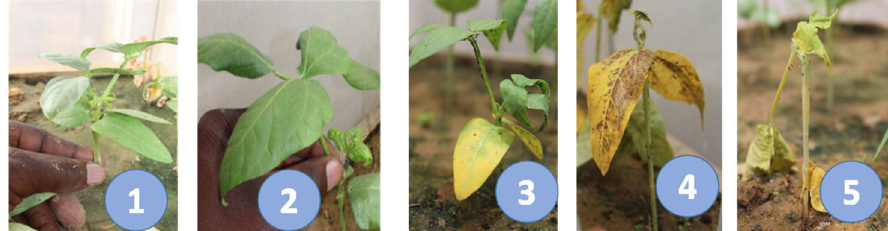
Figure 1. Aphid damage severity rating scale. The damage scored on a scale of 1–5 [7]), where 1 = no damage or symptoms on the leaves, 2 = fewer symptoms (one or two leaves showing aphid feeding symptoms), 3 = seedling leaves are partially yellow, 4 = seedling leaves totally yellow, and 5 = seedling plants are dead. Photo credit: Abou Togola.